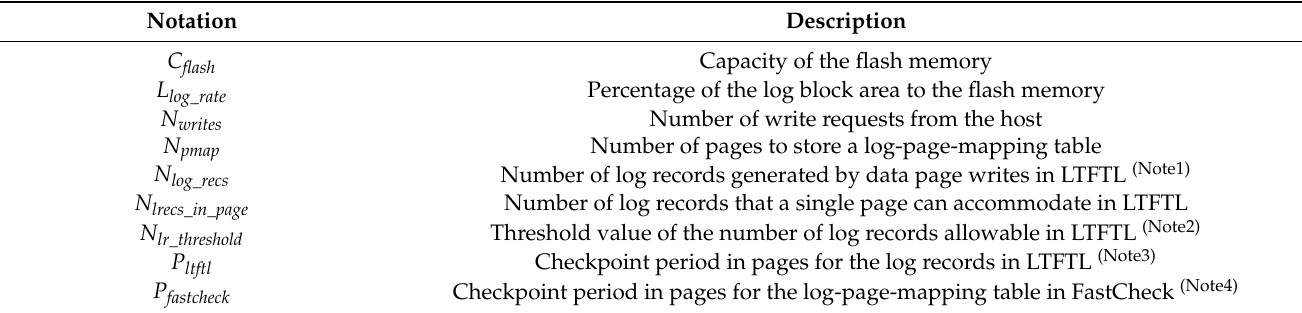
Table 1. Definition of the notation of the analytical